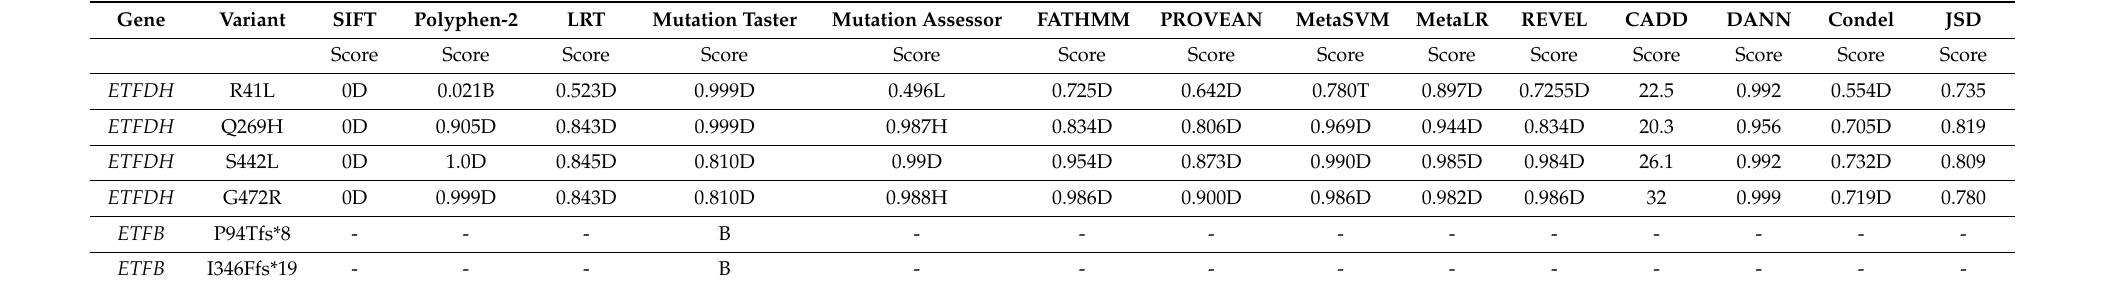
Table 3. In silico analysis of the studied ETFDH and ETFB